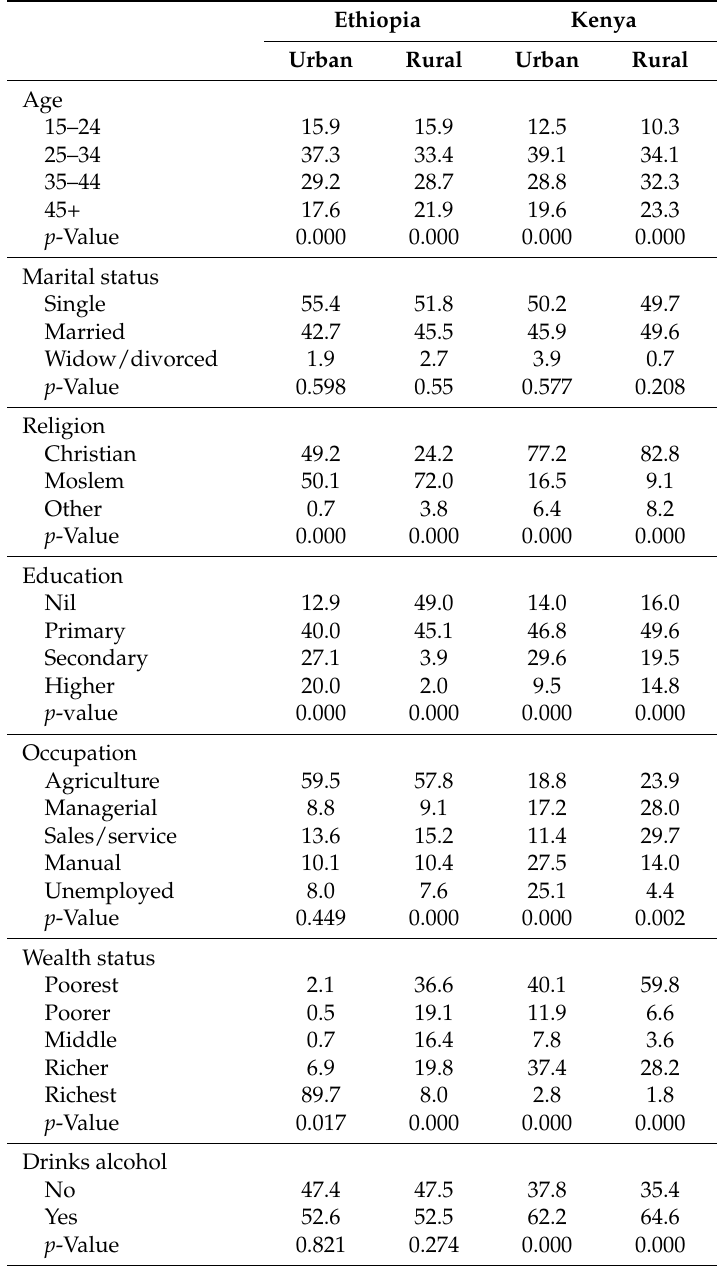
Table 4. Prevalence of smoking across the sociodemographic characteristics among men in Ethiopia and